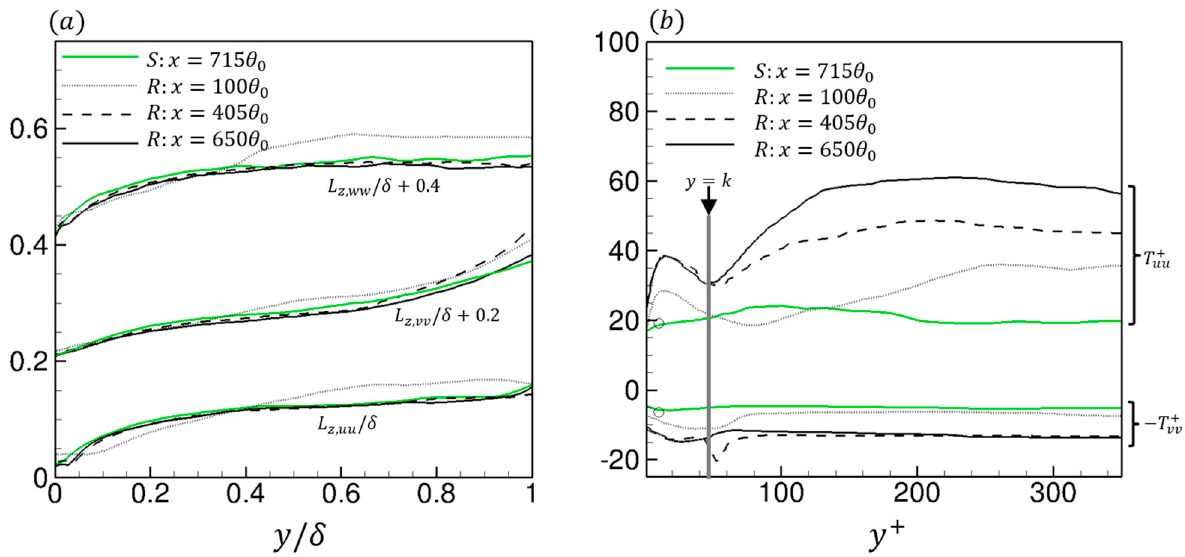
Figure 19. Wall-normal variation of the ( a ) integral length scale L z , αα / δ and ( b ) inner-scaled integral timescale T + αα at different streamwise stations above the rough and smooth walls. The profiles for L z , vv and L z , ww in ( a ) are shifted vertically while those for T + vv in ( b ) are multiplied by − 1 to provide clarity. Open symbols in ( b ): data by Quadrio and Luchini (2003) [56] at 𝑦 (cid:2878) = 10 . Like 𝐿 (cid:3053),(cid:3080)(cid:3080) , an integral timescale (𝑇 (cid:3080)(cid:3080) ) can be estimated by first calculating the two- point correlation of turbulent fluctuations in time (𝑅 (cid:3080)(cid:3080)(cid:3021) ) and then integrating it over the